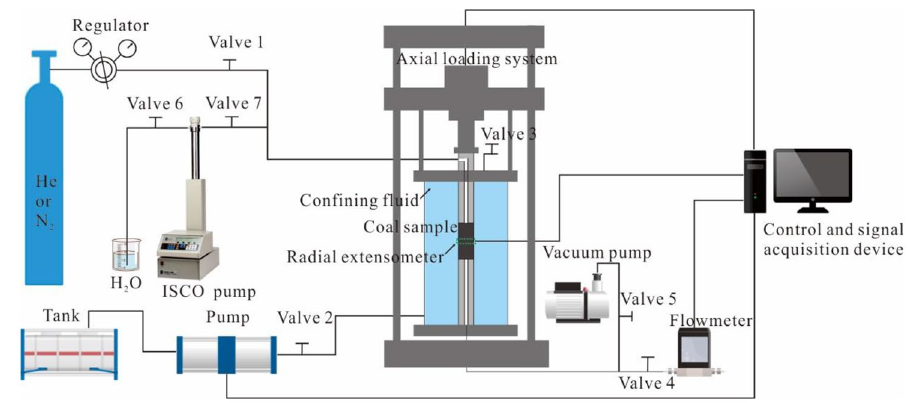
Fig. 1 Experimental